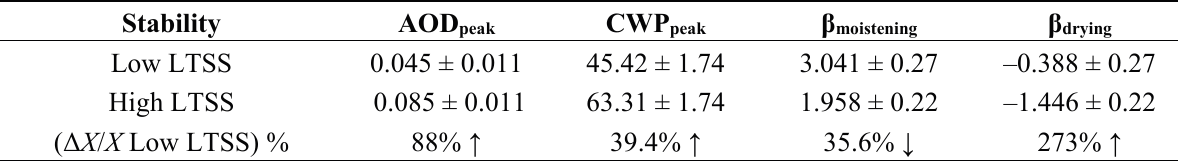
Figure 13. Response cloud water path (CWP) to increasing aerosol optical depth (AOD) in unstable and stable atmospheric environments for NAADR_Marine. The threshold AOD necessary to shift from moistening to drying processes is much larger in high LTSS environments than in low LTSS environments as well as the corresponding CWP. Table 7. Percent of increase ( ↑ ) or decrease ( ↓ ) in the characteristics parameters of cloud water path response curve aerosol induced perturbation from low to high lower tropospheric static stability (LTSS) environments for NAADR_Marine. Except for β moistening every other parameter increased significantly from unstable to stable environments.